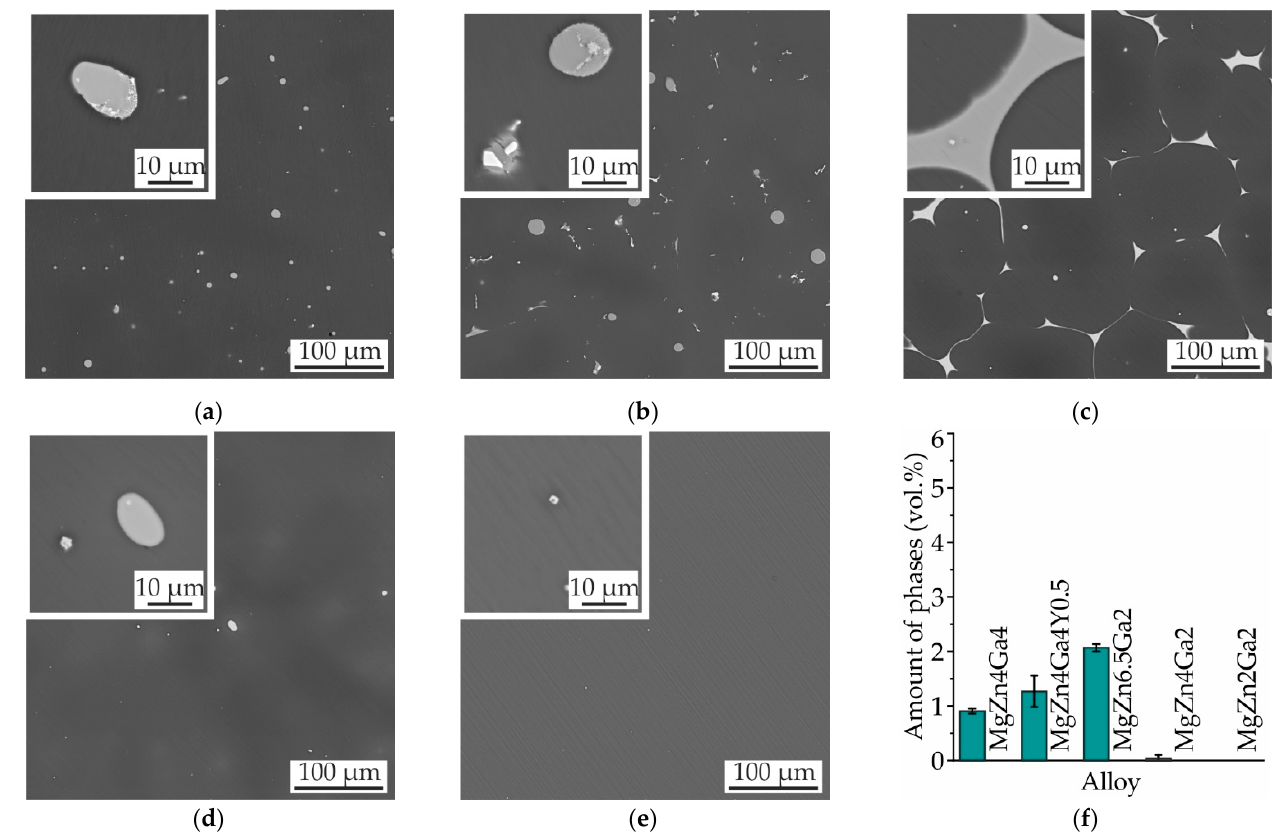
Figure 9. SEM micrographs of ( a ) MgZn4Ga4, ( b ) MgZn4Ga4Y0.5, ( c ) MgZn6.5Ga2, ( d ) MgZn4Ga2, and ( e ) MgZn2Ga2. ( f ) Amounts of intermetallic phases (Mg 7 Zn 3 , Mg 5 Ga 2 , and GaY) in the alloys after T4 heat treatment.